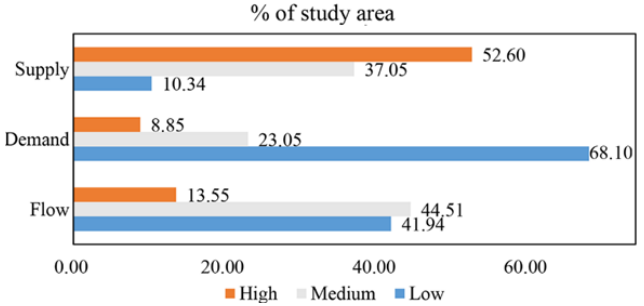
Figure 2. Distribution of agricultural CES values.